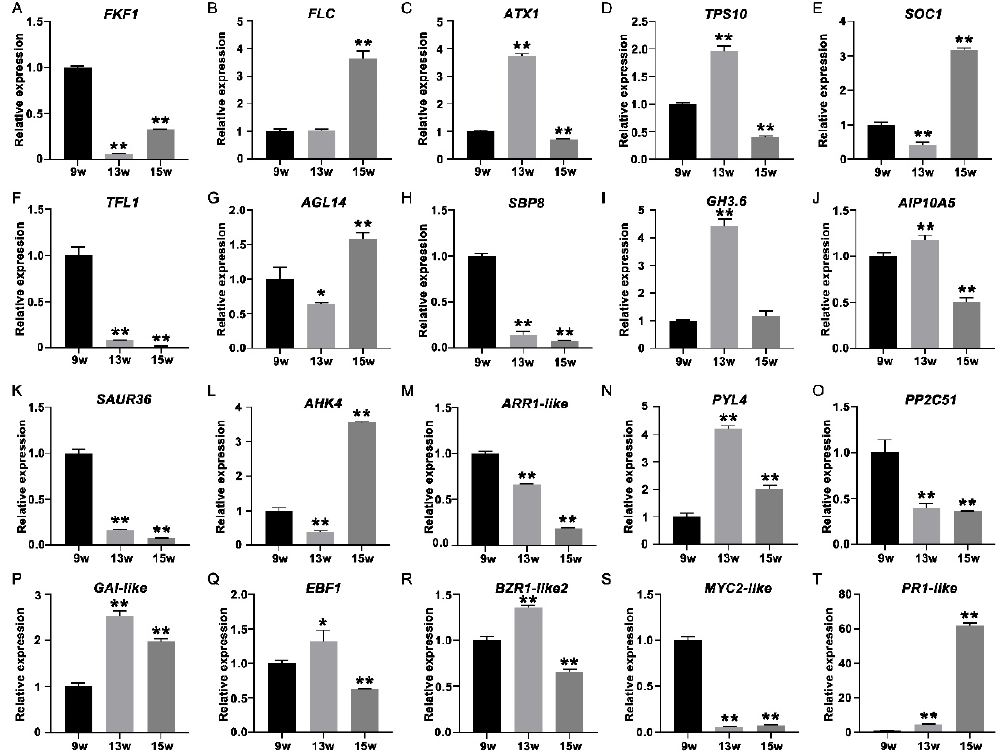
Figure 10. QRT-PCR analysis of 24 strawberry genes that showed differential expression at 9 w, 13 w, and 15 w to verify the RNA-seq data. ( A – T ) QRT-PCR identification of DEGs mentioned in the above text. Error bars indicate the standard deviation (SD) for three biological replicates. (* p < 0.05, ** p < 0.01).